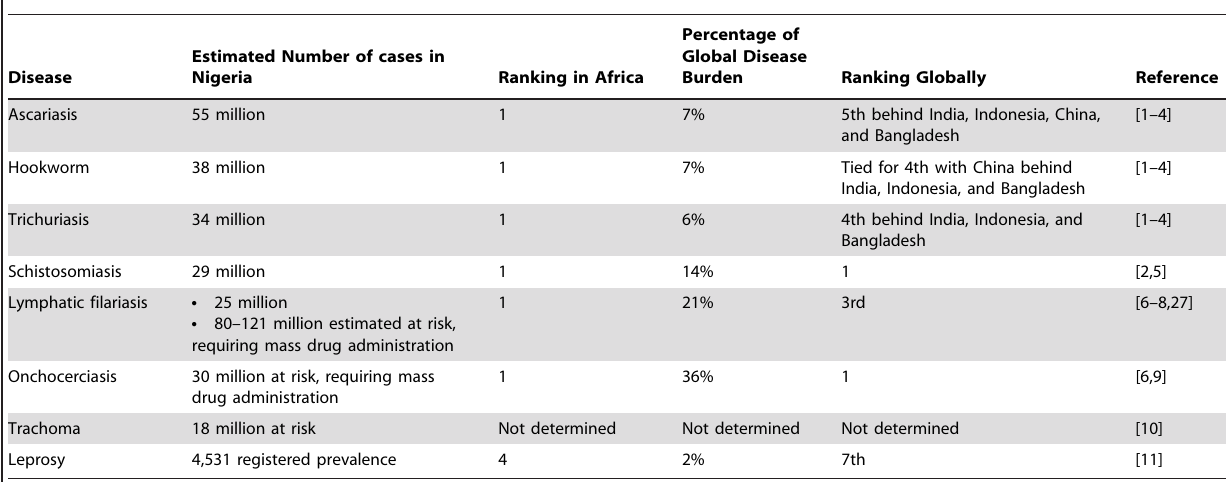
Table 1. Ranking of Nigeria by neglected tropical diseases cases and prevalence.